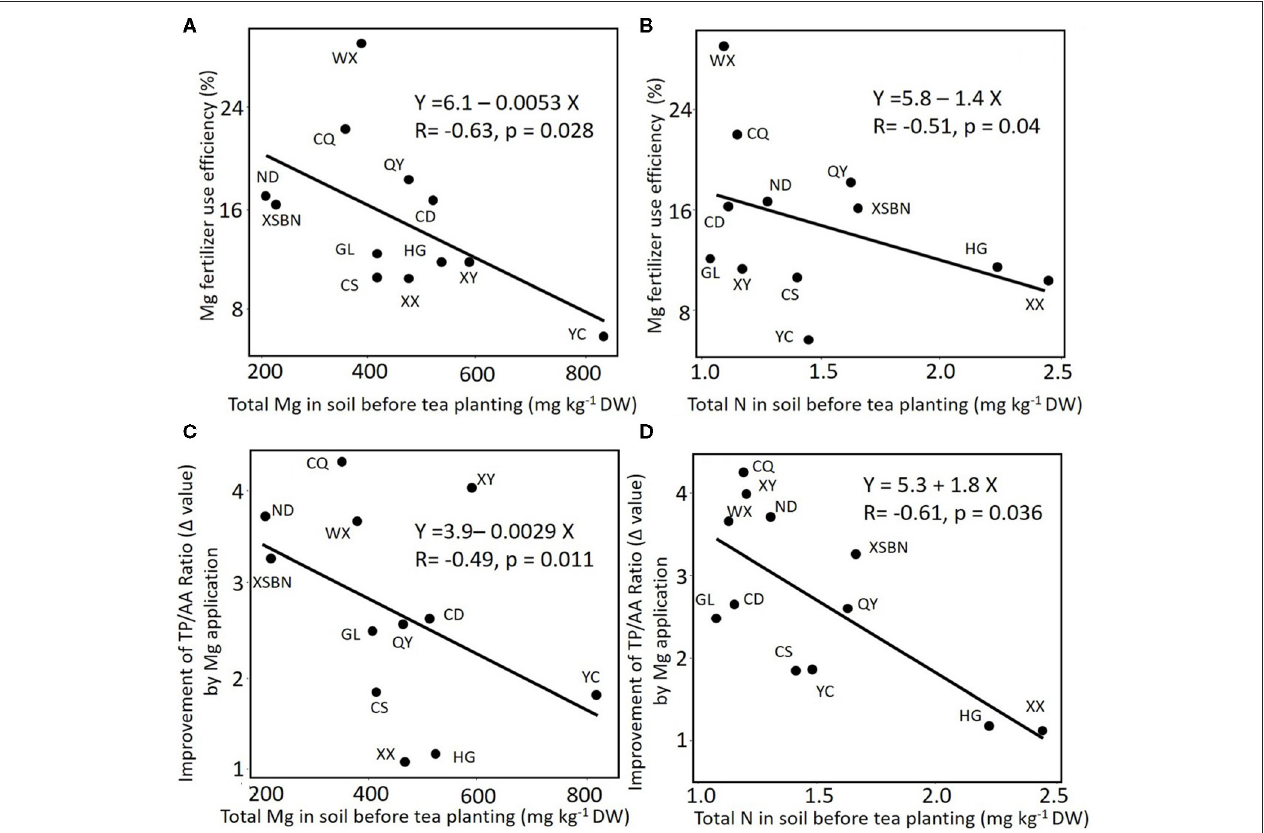
FIGURE 3 | The correlation between content of total magnesium (A,C) or nitrogen (B,D) in soil and magnesium fertilizer use efficiency (A,B) or change of TP/AA ratio ( 1 value) pre- and posttea plant cultivation in tea leaves (C,D) . Total Mg was extracted with nitric acid, perchloric acid and hydrofluoric acid from soil. XY, Xsbn, WX, CD, HG, YC, QY, CS, GL, XX, ND, and CQ indicated that the soil has been collected in the site of Xinyang, Xishuangbanna, Wuxi, Chengdu, Huanggang, Qingyuan, Changsha, Guiling, Xiangxi, Ningde, and Chongqing,